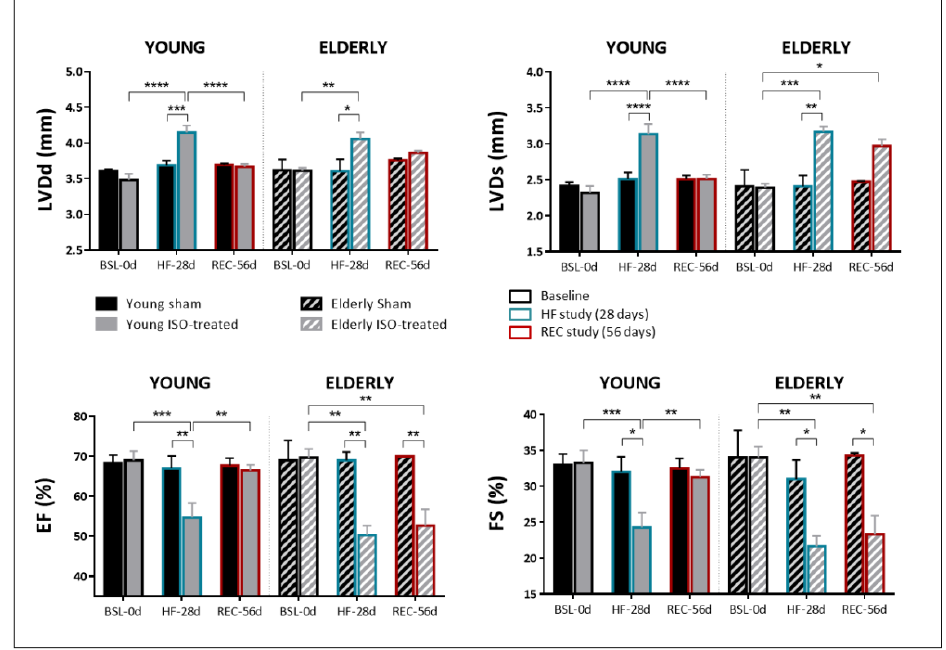
Figure 3. Echocardiographic parameters at baseline (black outlined bars), after 28-day exposure to saline or isoproterenol infusion (HF-28d, blue outlined bars) and at 56 days after exposure + recovery period (REC-56d, red outlined bars) in young and elderly mice. LVDd: End-diastolic left ventricular diameter; LVDs: End-systolic left ventricular diameter; IVS: interventricular septum thickness; PW: posterior wall thickness; EF: ejection fraction; FS: fractional shortening). N = 6/7 in sham/ISO-treated young mice; N = 3/4 in sham/ISO-treated elderly mice. * p < 0.05, ** p < 0.01, *** p < 0.001, **** p < 0.0001.